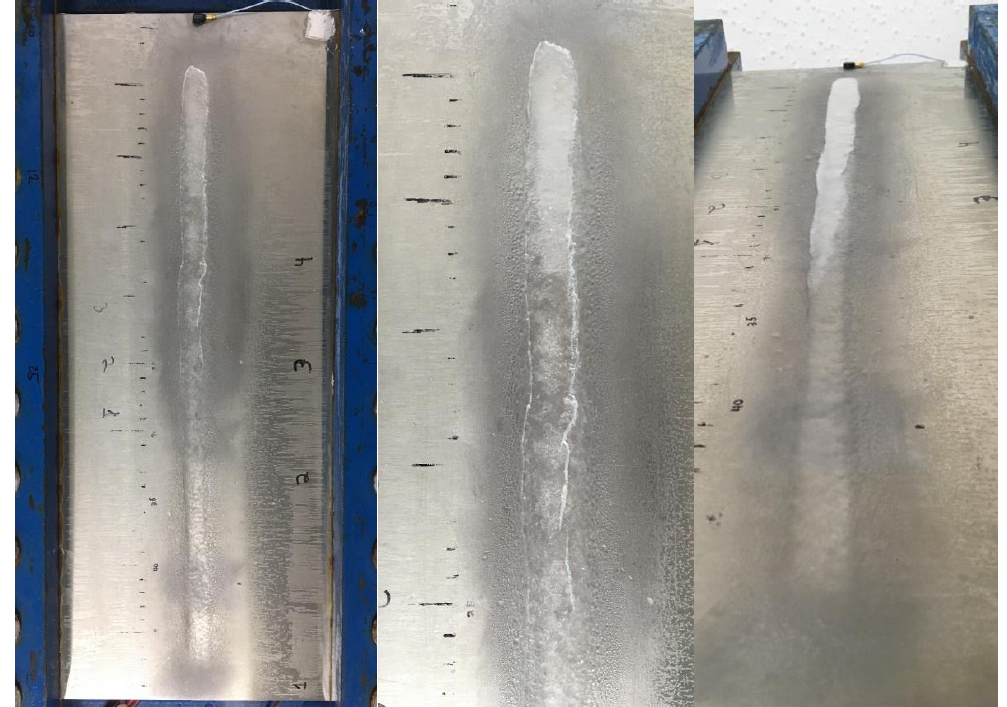
Figure 15. Delamination of the ice at 550 Vpp in steady-state activation with all piezoelectric actuators activated in phase at 185 Hz.